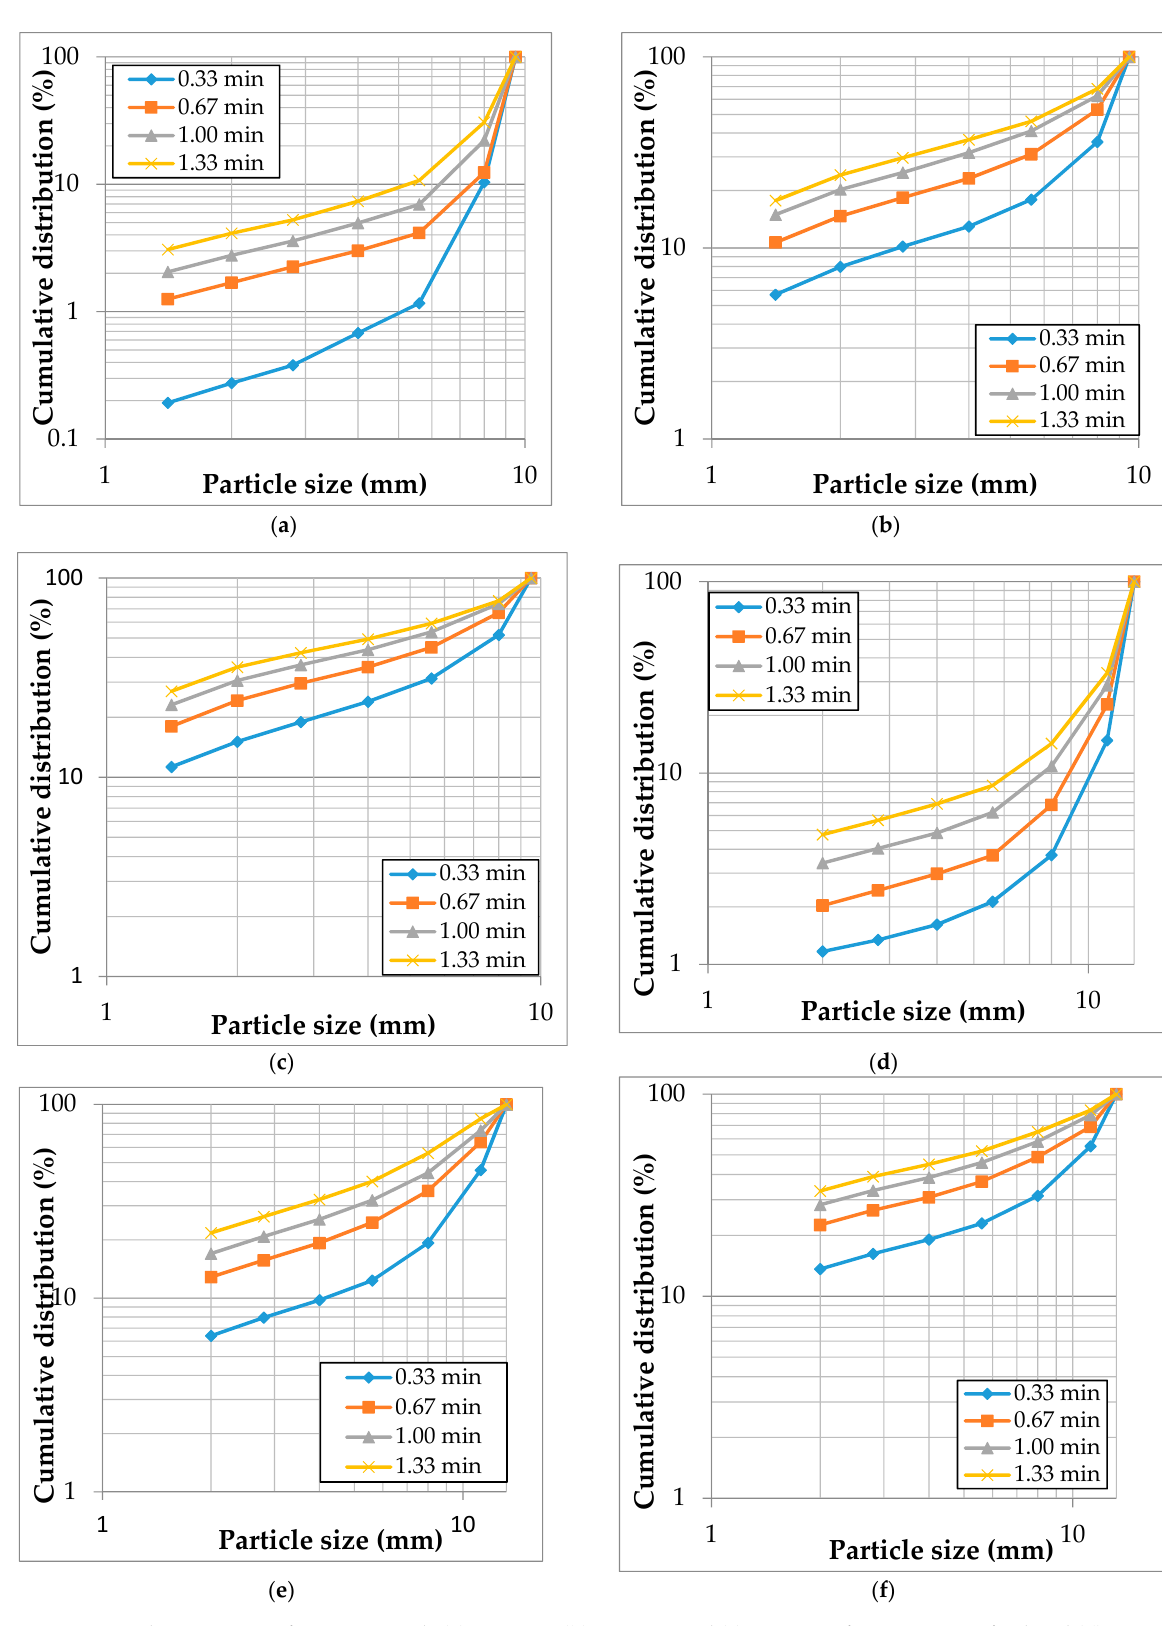
Figure 8. Cumulative passing for rotor speeds ( a ) 510 rpm, ( b ) 885 rpm and ( c ) 1040 rpm for -9.5 +8 mm feed and ( d ) 510 rpm, ( e ) 885 rpm, and ( f ) 1040 rpm for -13.2 +12.2 mm feed size.